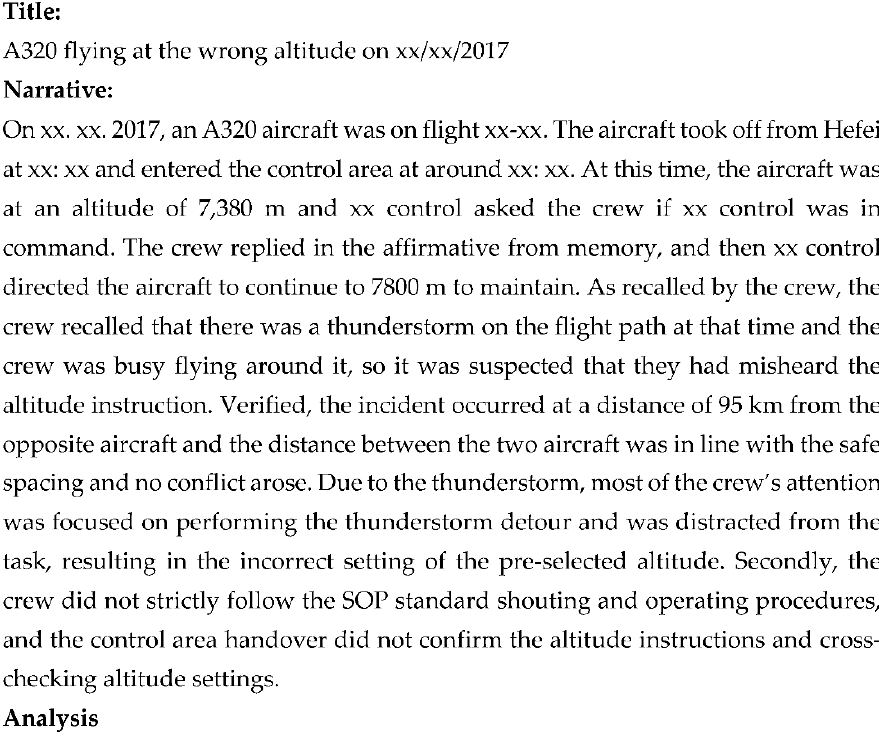
Figure 1. An example of an aviation incident report in Chinese ( a ) and its English version ( b ).